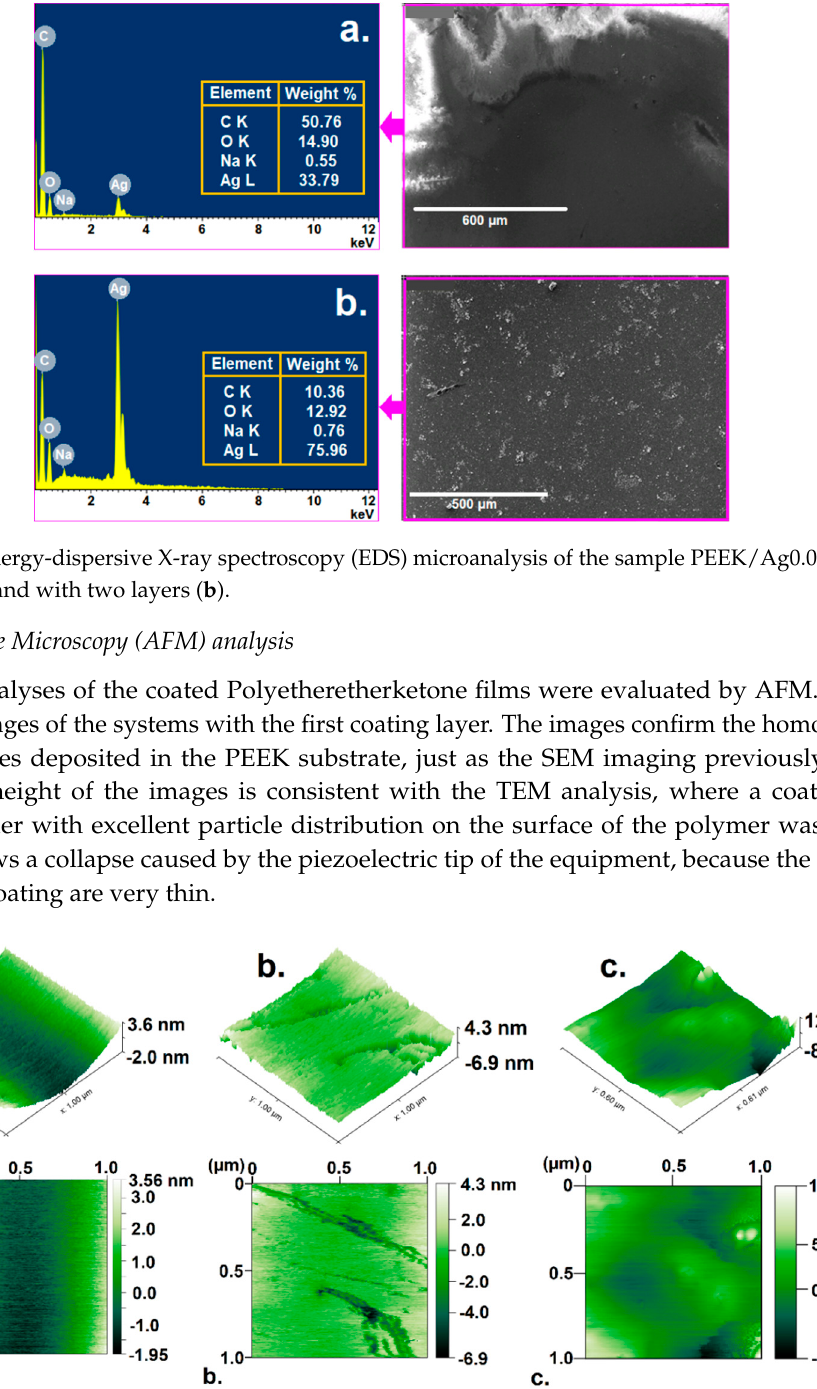
Figure 10. Atomic force microscopy (AFM) images of the (a) PEEK/Ag0.04, (b) PEEK/Ag0.08 and (c) PEEK/Ag0.12 systems with one layer.